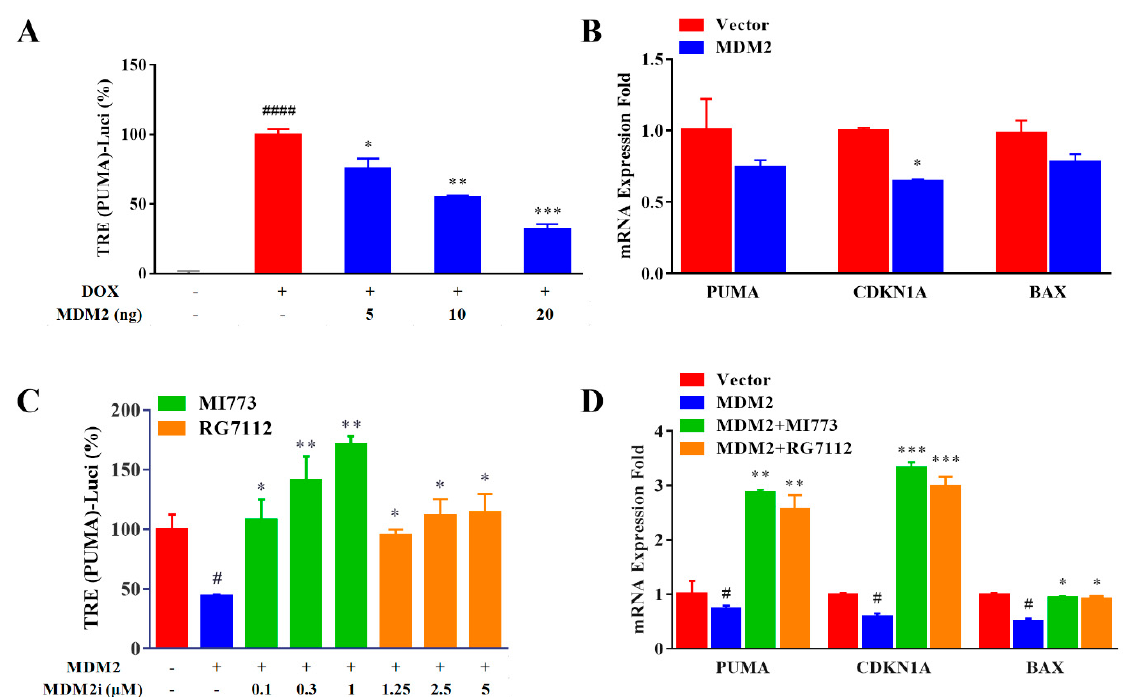
Figure 6. Improved reporter gene system was applied for evaluating MDM2 inhibitors. ( A ) The trans- fected overexpression of MDM2 decreased the reporter gene signal of PUMA in a dose-dependent manner ( n = 3). ( B ) RT − qPCR analysis to verify the influence of transfected MDM2 plasmid (20 ng per well) on reporter gene system ( n = 3). ( C ) MDM2 inhibitors (MI773 and RG7112) were tested by the PUMA reporter gene in MDM2 − overexpressed NCIH1299 − wtP53 ( n = 3). ( D ) RT-qPCR analysis to verify the influence of MDM2 inhibitors (1 µ M MI773 or 5 µ M RG7112) on the transcriptional level of P53 target genes ( n = 3). Data are presented as the mean ± S.D. obtained from three separate experiments. Compared to the non-DOX group in (A), #### p < 0.0001; compared to the DOX but non- MDM2 group in ( A ), * p < 0.05, ** p < 0.01, and *** p < 0.001; compared to the corresponding vector group in ( B ), * p < 0.05; compared to the non-MDM2 group in ( C , D ), # p < 0.05; compared to the MDM2 group in ( C , D ), * p < 0.05, ** p < 0.01, and *** p < 0.001.